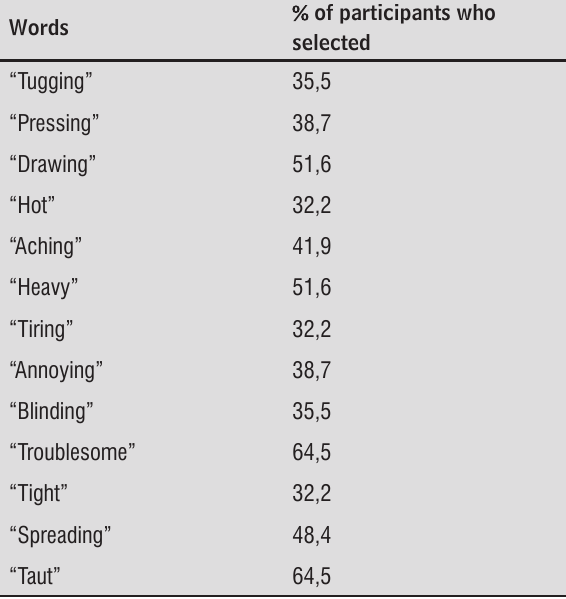
Table 2 - Br-MPQ most frequently chosen words selected